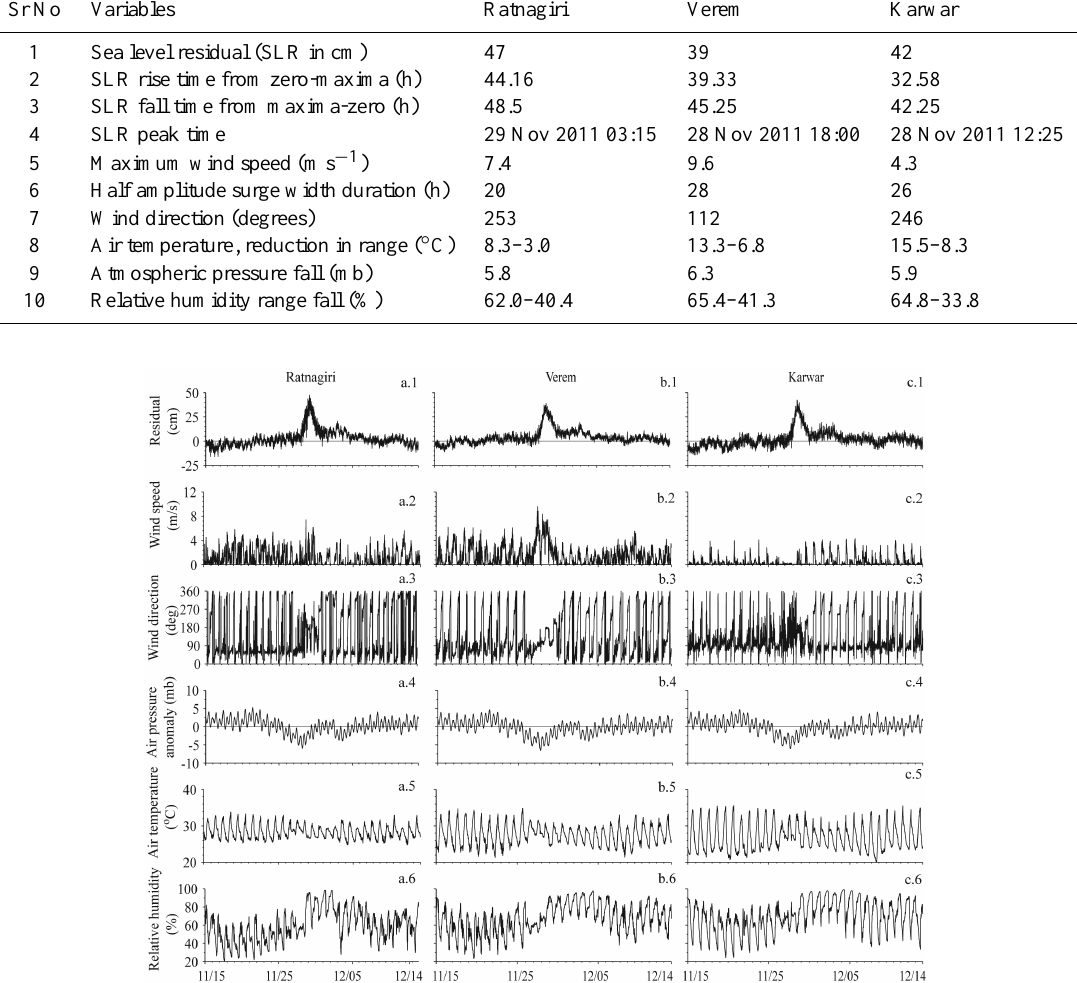
Figure 4. Sea level residual and surface meteorological parameters during the episodic event E1. (a.1 to a.6) SLR, wind speed, wind direction, atmospheric pressure anomaly, air temperature and relative humidity at Ratnagiri, Maharashtra. (b.1 to b.6) same as in (a) at Verem, Goa. (c.1 to c.6) same as in (a) at Karwar, Karnataka. The atmospheric pressure anomaly is estimated by subtracting the mean atmospheric